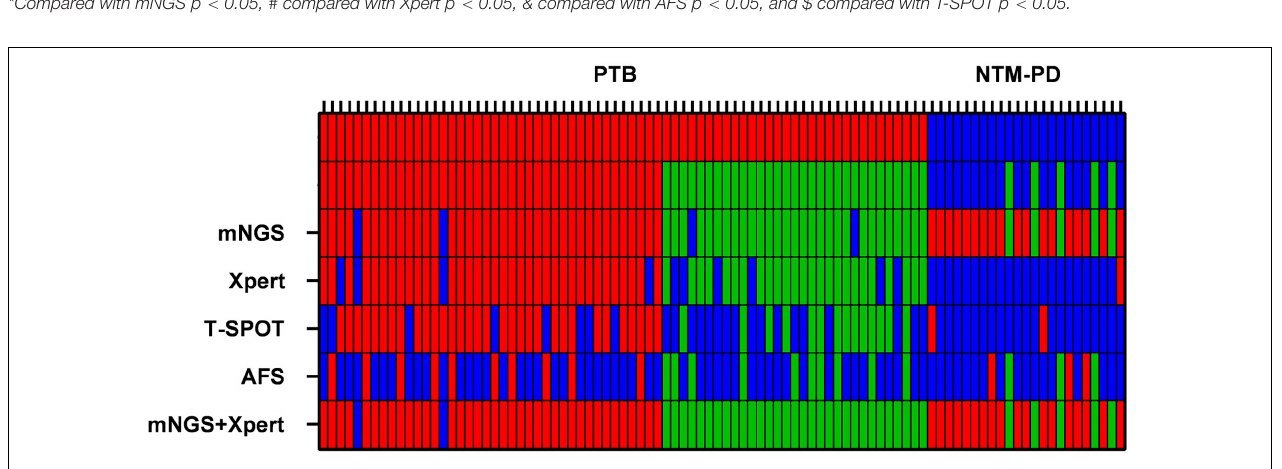
FIGURE 2 | Heat maps indicating the performances of mNGS, Xpert, AFS (BALF samples), and T-SPOT (sera samples) in the diagnosis of MTB and NTM. The red bars indicate that MTB and NTM were detected correctly. The green bars indicate that MTB and NTM were detected correctly in immunocompromised